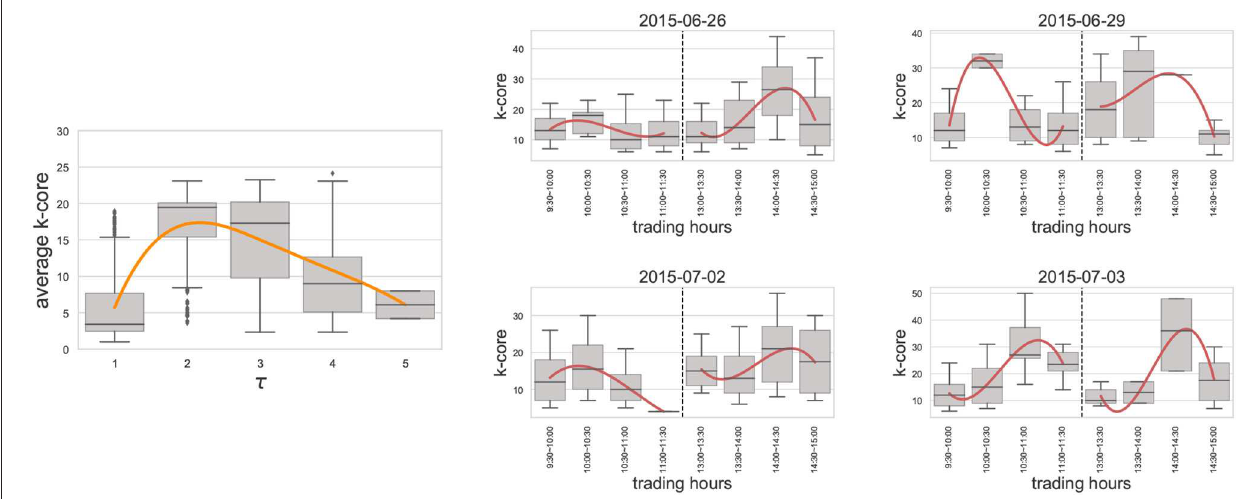
FIGURE 5 | The k -core index of stocks reaching the limit down prices. The left panel presents the averaged k -core index at each τ in the simulation course from the proposed contagion model. The boxes show the distribution of the averaged k -core index at τ . The smooth line (orange) shows the trend of the mean of the averaged k -core index at each τ . The right panel which contains four subplots shows the k -core indexes of stocks reaching the limit down prices in four market crashing days. The smooth lines (red) depict the trend of the mean of the stocks’ k -core indexes. The gray dotted lines imply the lunch breaks. For the purpose of clearly visualizing data, outliers have been